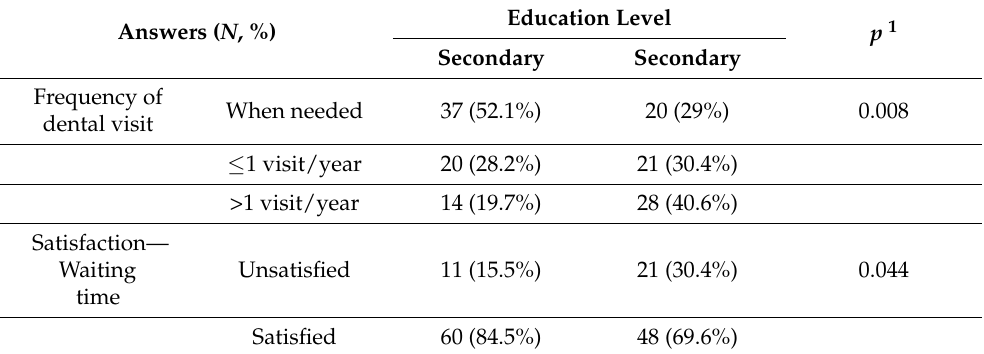
Table 6. Distribution of the participants according to education level and certain answers in the